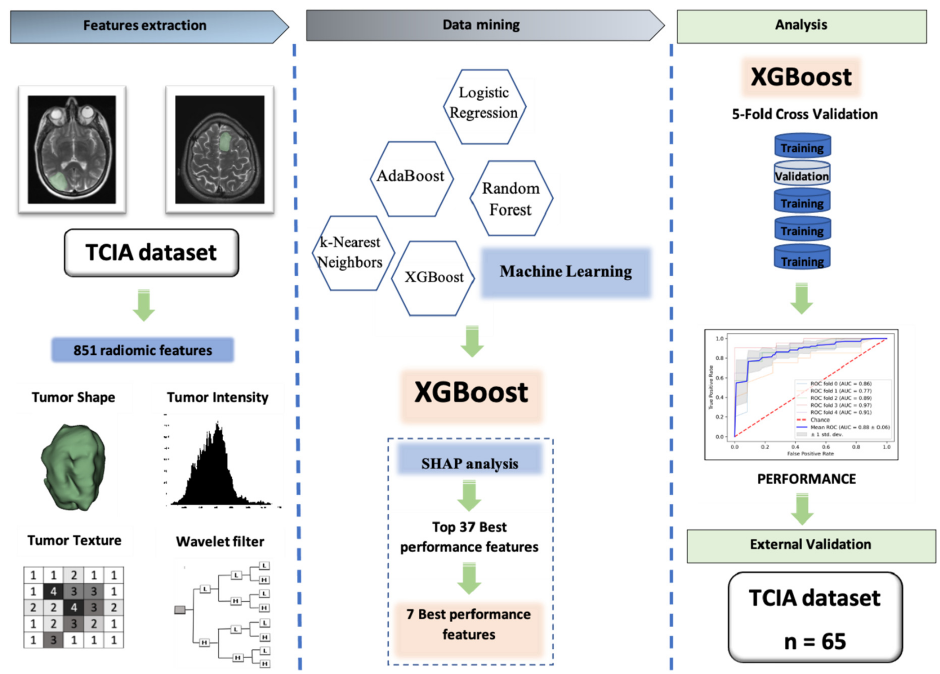
Figure 4. The workflow of our study. Firstly, data was extracted from two public database from former articles, one database was used for training and another one was used as the external test set; secondly, radiomic feature extraction and feature selection were performed using SCC, XGBoost, and SHAP analysis; finally, machine learning algorithm XGBoost classifier was applied on refined features to predict the 1p/19q codeletion status of LGG patients on training and external test